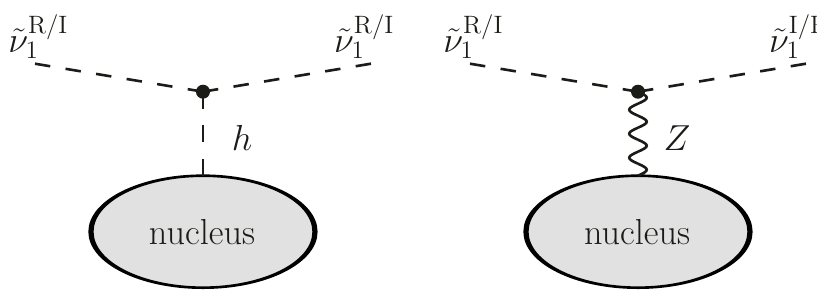
Figure 7 . The relevant DM direct detection